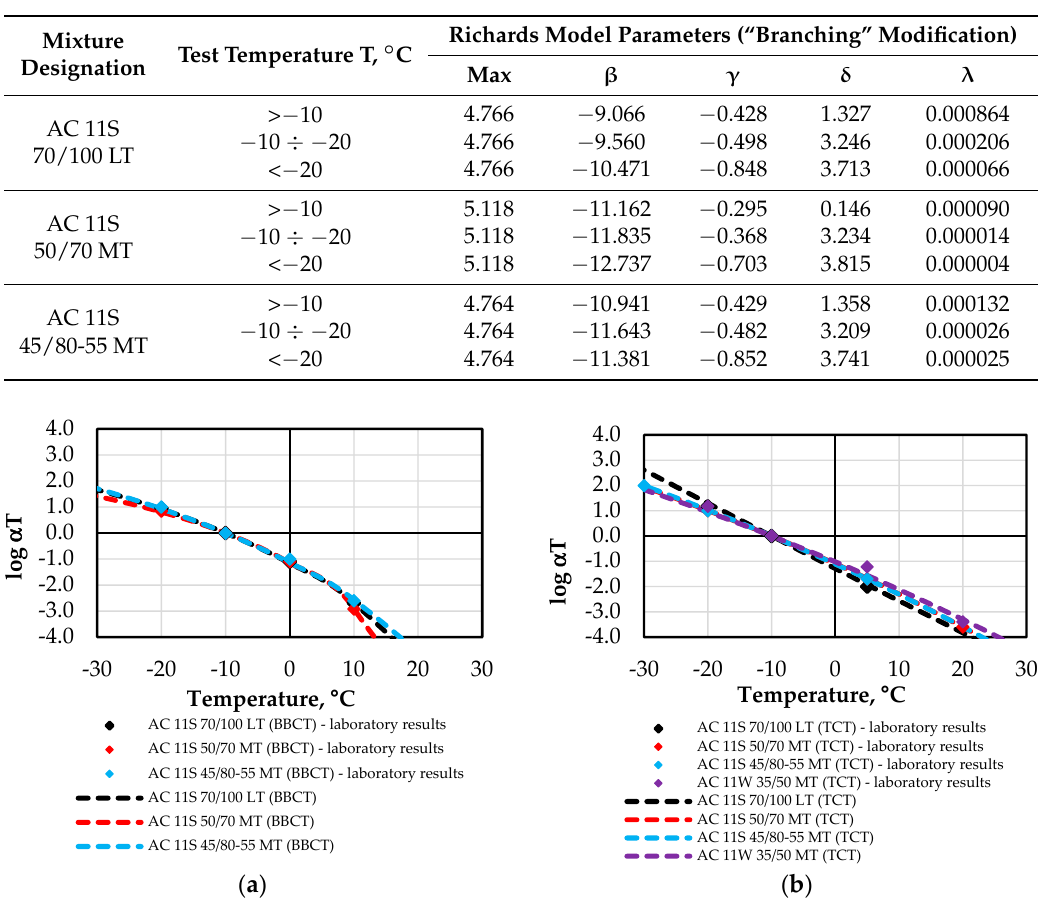
Table 7. Master curve parameters for the Bending Beam Creep Test (BBCT).